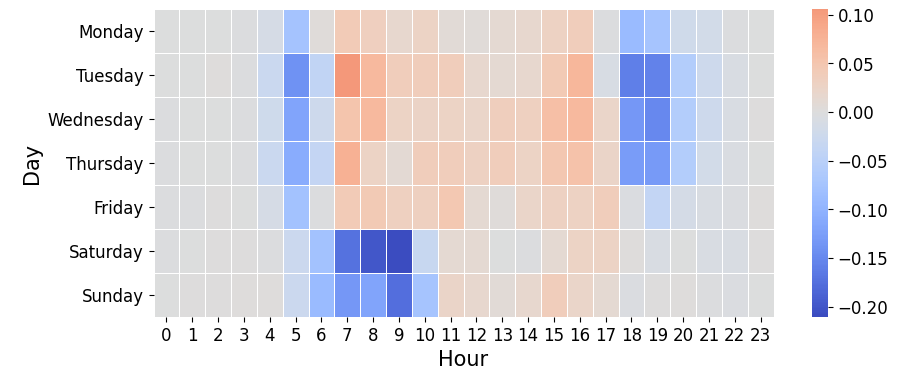
Figure 5. Positive (red) and negative (blue) absolute change in normalized activity counts from 2019 to 2020.